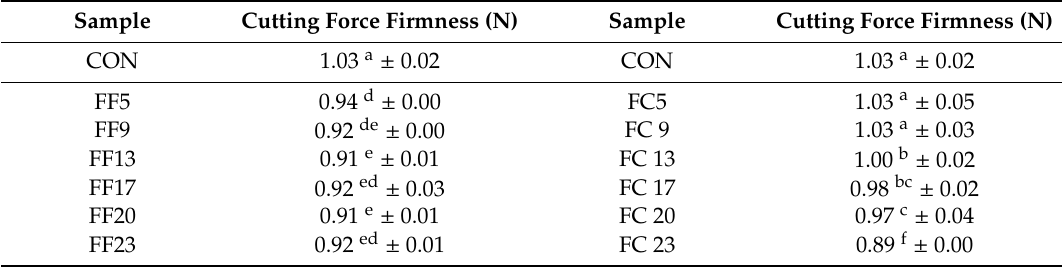
Table 4. The strength test for pasta with flaxseed flour (FF) and flaxseed cake